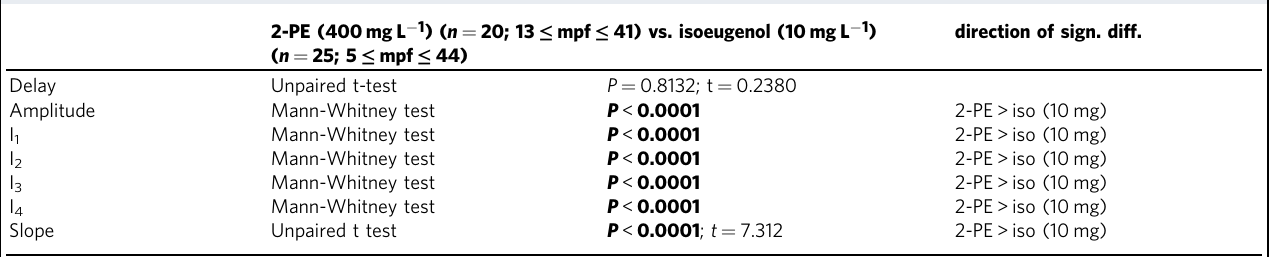
iso Isoeugenol, mpf Measurement repetitions per fi sh, sign. diff. Signi fi cant difference, for signi fi cant differences P -values are highlighted (in bold), n indicates the number of independent animal